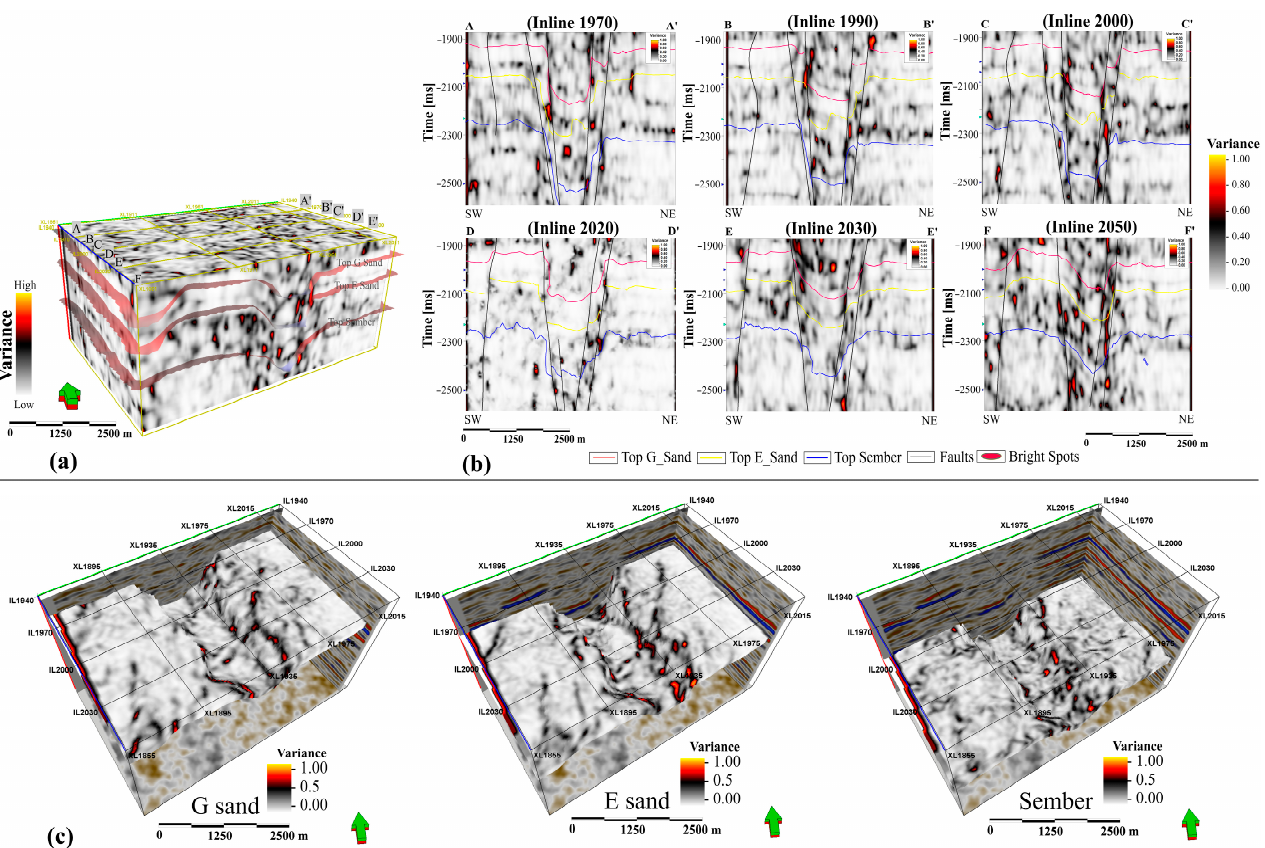
Figure 12. ( a ) 3D variance edge attribute volume, ( b ) 2D extracted variance cross-sections, and ( c ) 3D variance horizon slices of the G sand interval, the E sand interval, and the Sembar Formation showing discontinuities.